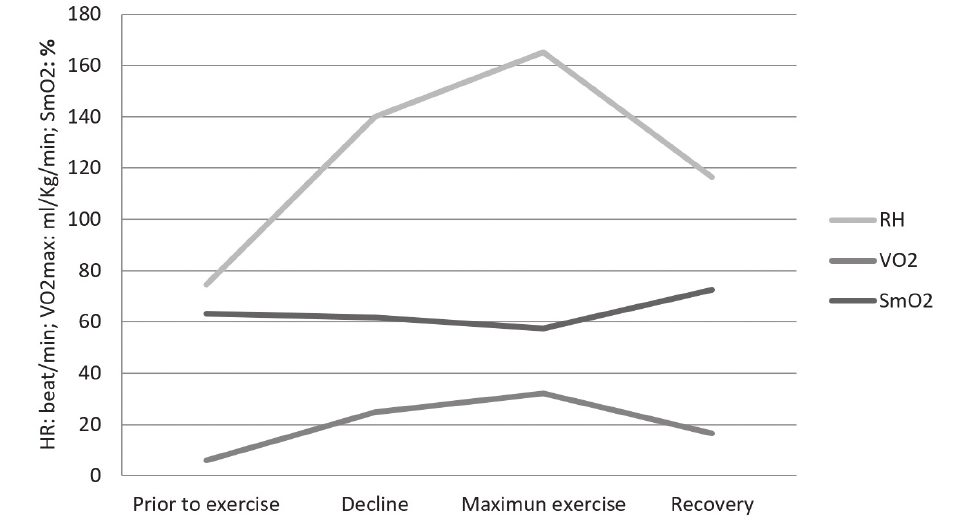
FIGURE 3. Evolution of SmO